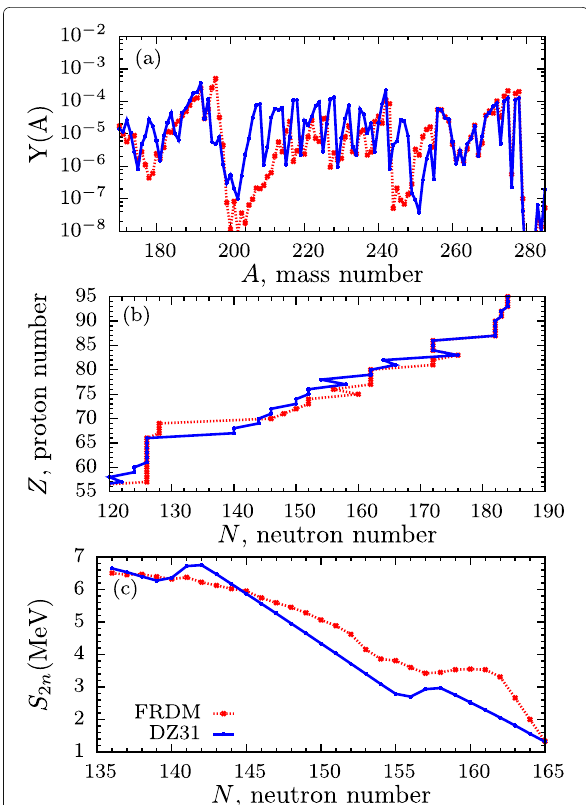
Fig. 2 Comparison of the abundance Y ( A ) ( a ), r -process path ( b ), and the two-neutron separation energy S 2 n ( N ) for Z = 78 ( c ) from calculations with Y e = 0.07, for trajectory with an initial entropy per nucleon s = 10 k B and a dynamical timescale τ = 10 ms. The red dotted and blue solid lines are obtained with the FRDM and the DZ31 mass model, respectively. For both cases, S 0 2 n (cid:4) 3 MeV